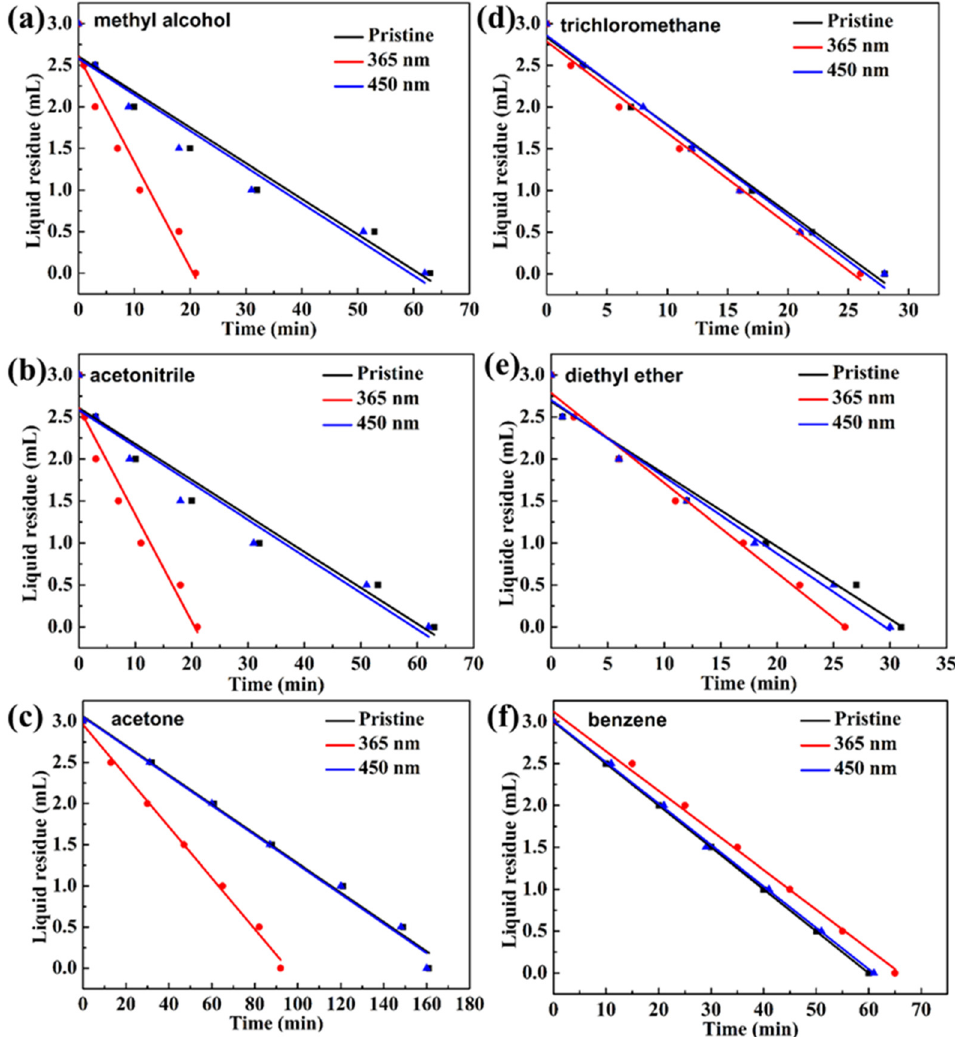
Figure 3. Diffusion flux of polar ( a – c ) and non-polar gas molecules ( d – f ) (the flow rate of methanol ( a ); acetonitrile ( b ); acetone ( c ); trichloromethane ( d ); diethyl ether ( e ), and benzene ( f )) (pristine (black); after UV irradiation (red); after visible light irradiation (blue)). Table 1. Diffusion flux of polar and non-polar gas molecules under different conditions (pristine and under UV–Vis irradiation).